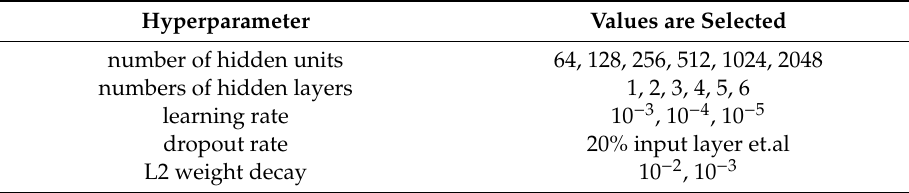
Table 4. Hyperparameter settings of the neural